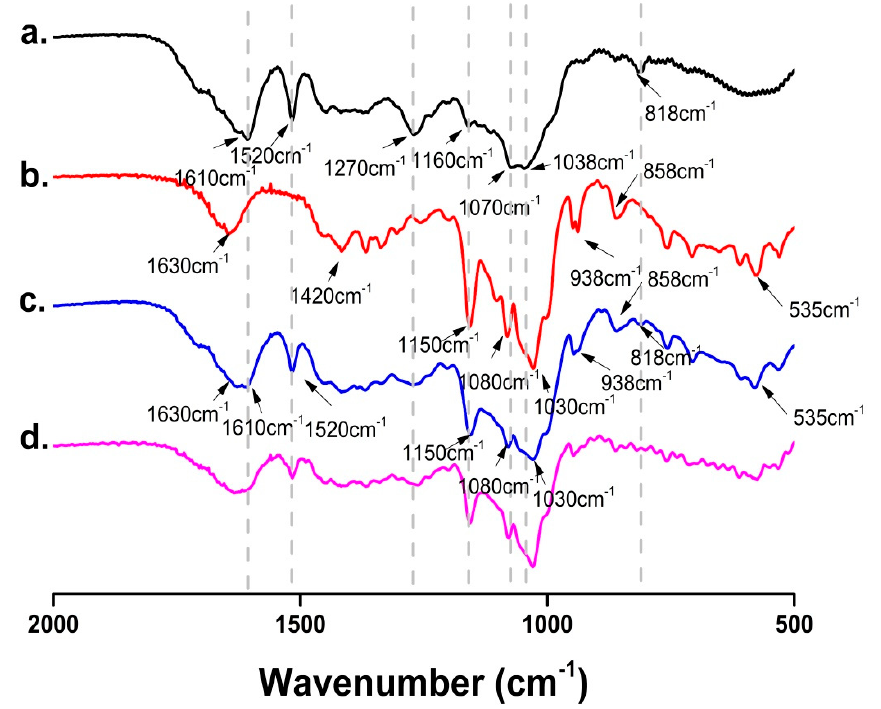
Figure 5. FT-IR spectra of ( a ) Forsythia suspensa leaf extract (FSE), ( b ) β -CD, ( c ) β -CD-assisted extract of Forsythia suspensa leaves (FSE- β -CD) and ( d ) β -CD with Forsythia suspensa leaf extract 1:1 physical mixture (FSE/ β -CD PM).